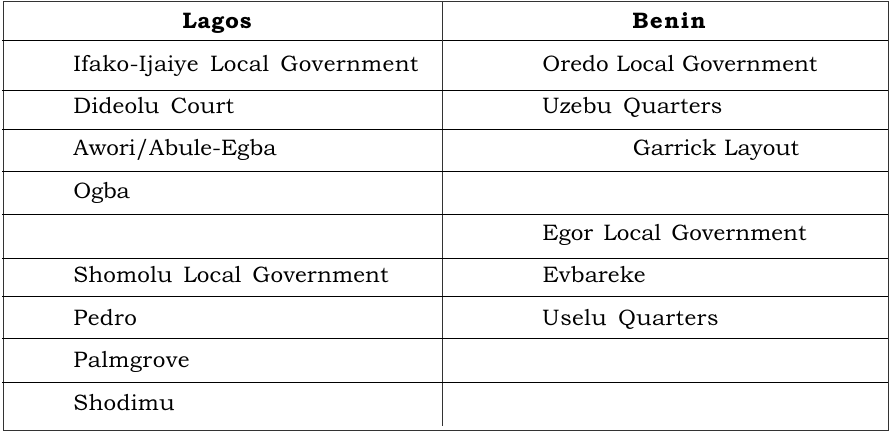
Table 1. Selected